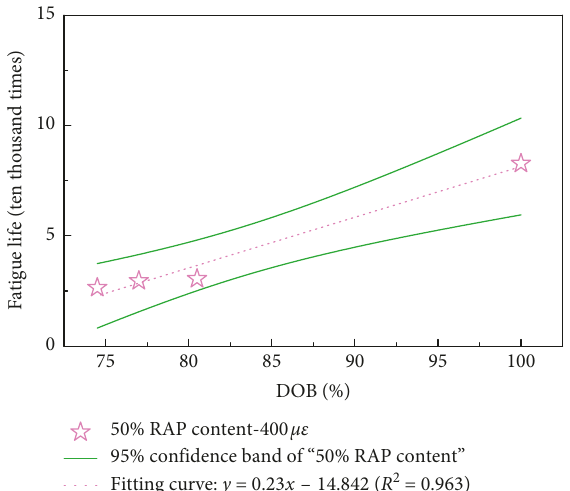
Fitting curve: y = 0.23 x – 14.842 ( R 2 = Figure 5: Confidence interval of the fitting curve between DOB and pavement